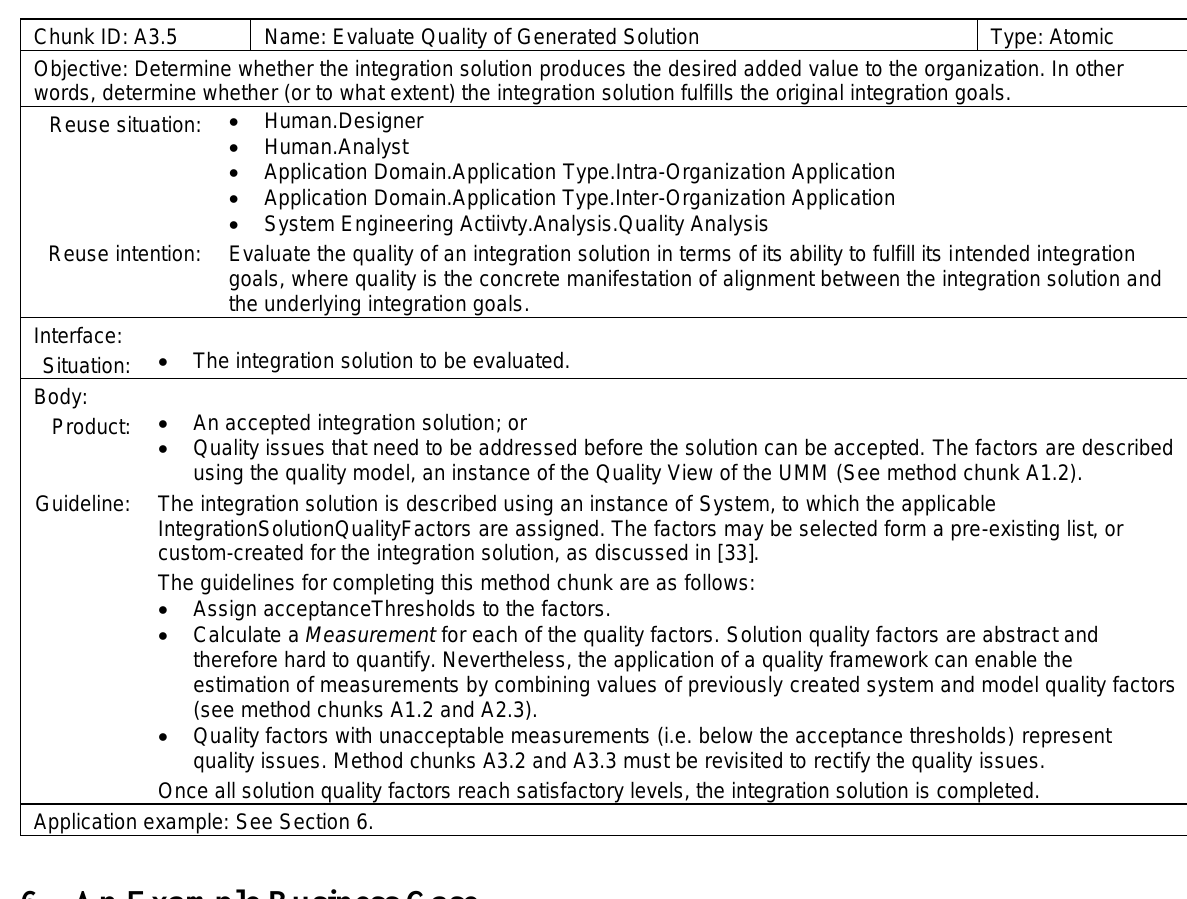
Table 12. Definition of method chunk